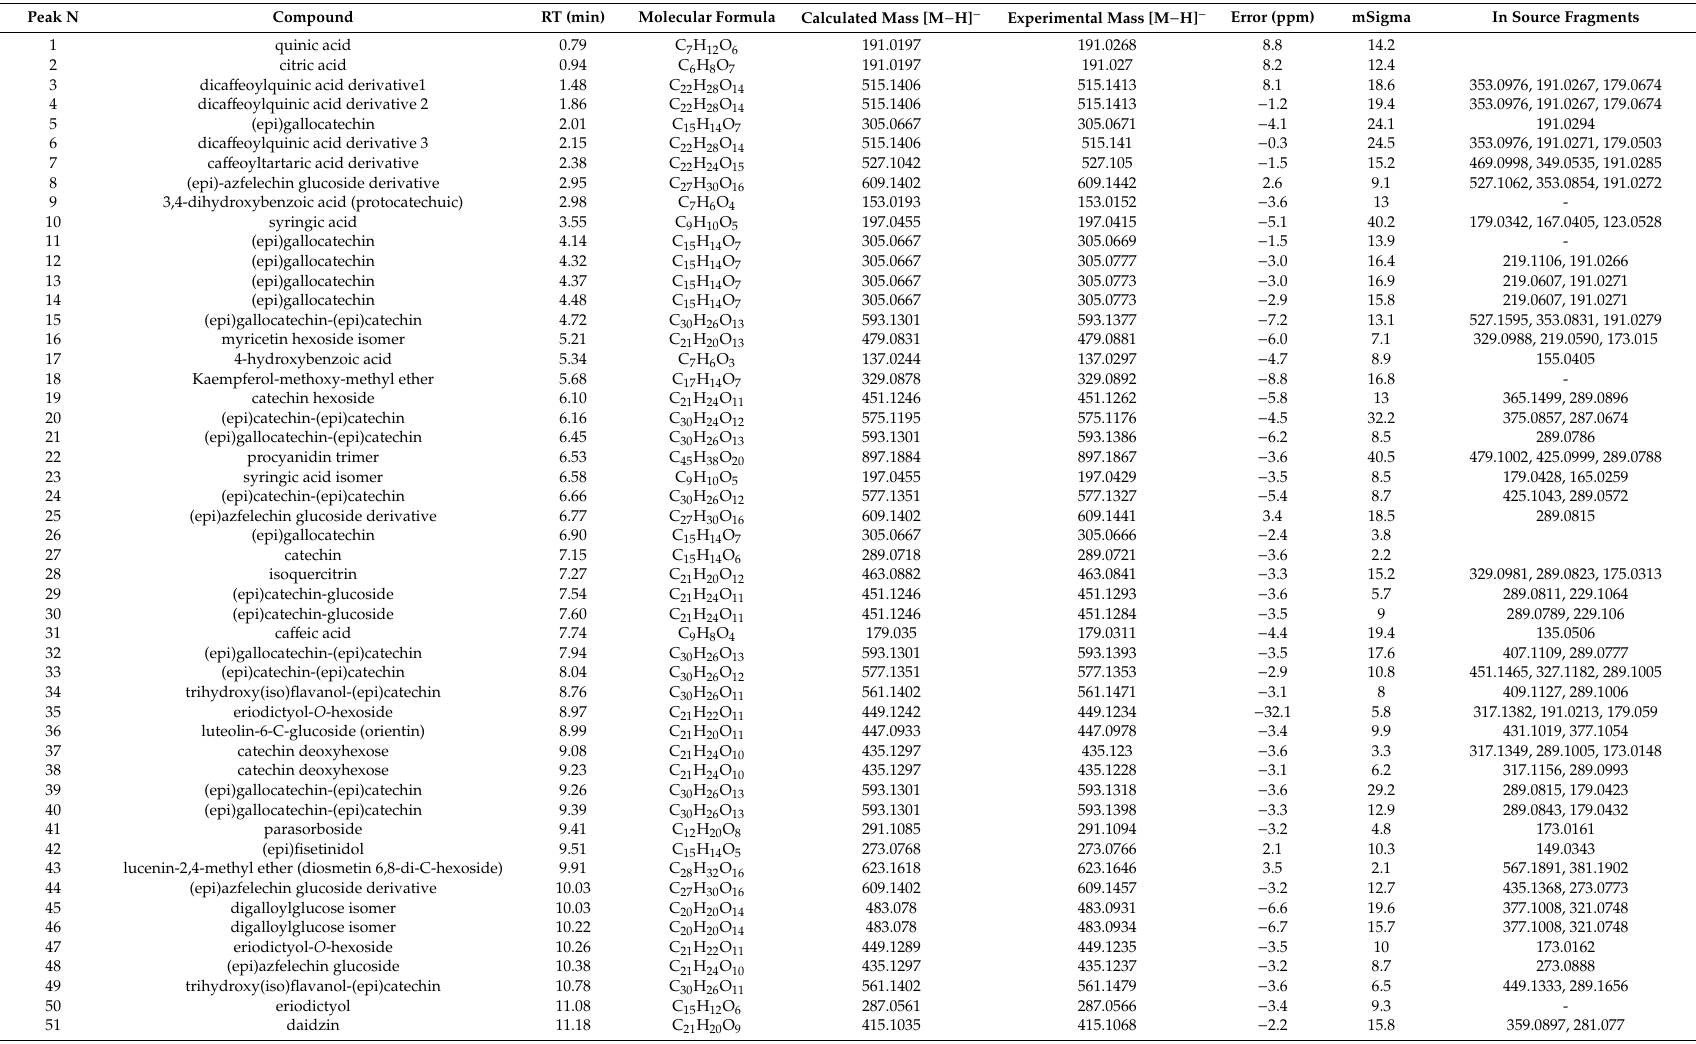
Table 2. Phenolic compounds identified as free and bound forms in banana passion fruit